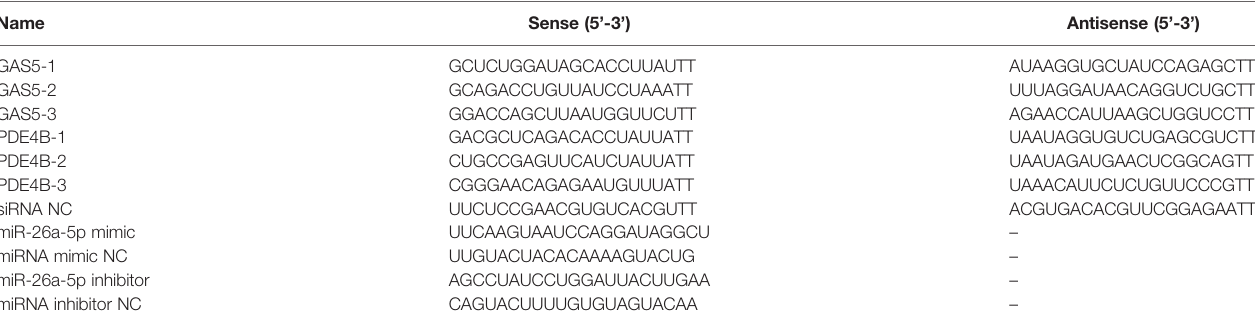
TABLE 1 | Small interfering RNAs (siRNAs) used in this